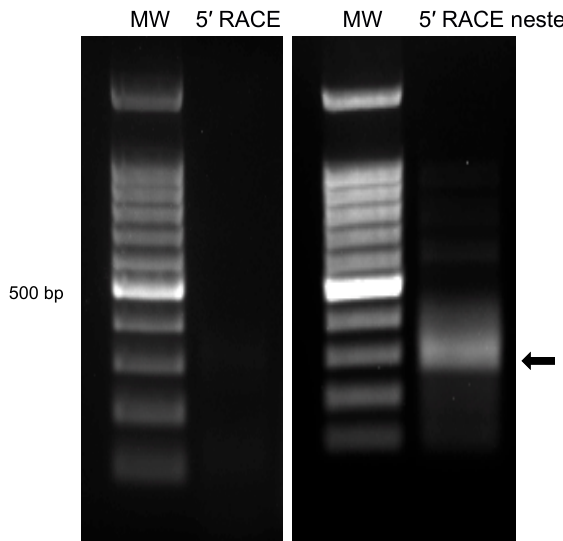
Figure 4. 5 ′ RACE product for ORF-A . Infected cells were subjected to mRNA isolation followed by RACE protocol (Invitrogen GeneRacer) to map the 5 ′ terminus of the ORF A transcript. After the initial primers lead to poor PCR amplification ( left ), a nested PCR ( right ) was performed using the initial RACE product as a template. The 300 bp amplicon (black arrow) was excised and sent for sequencing.